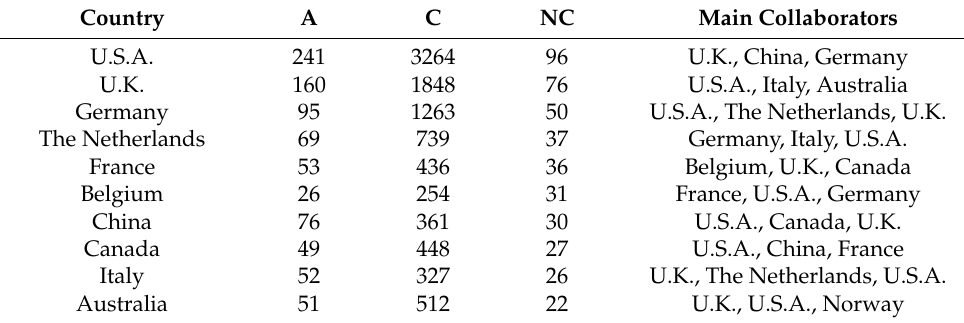
Table 5. Top 10 most cooperative countries and main collaborators.